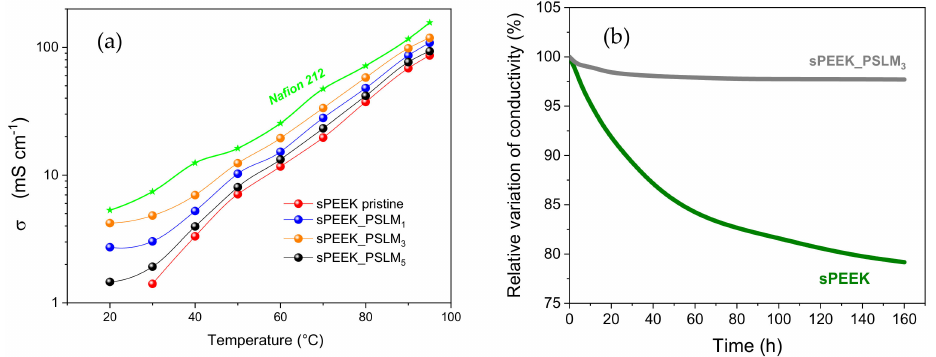
Figure 7. ( a ) Proton conductivity of sPEEK membranes and Nafion 212 at 90 ◦ C as a function of RH. ( b ) Hydrolytic stability for sPEEK and sPEEK_PSLM 3 membranes at 90 ◦ C and 95% RH during 160